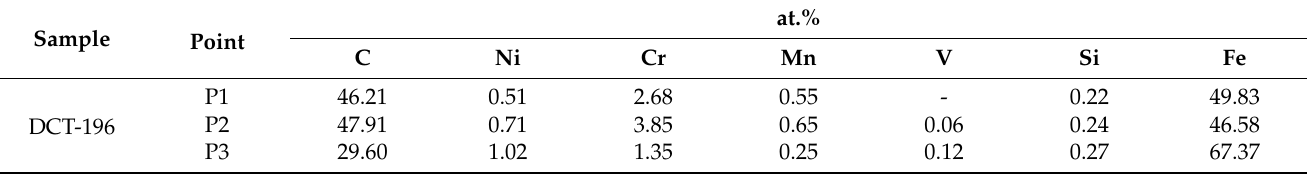
Figure 4. SEM images of the samples at 0.2 mm from the surface: ( a ) CHT, ( b ) CT-80, ( c ) SCT-150, and ( d ) DCT-196; Pictures after PS processing: ( e ) CHT, ( f ) CT-80, ( g ) SCT-150, and ( h ) DCT-196; and histogram of carbide calculation results: ( i ) CHT, ( j ) CT-80, ( k ) SCT-150, and ( l ) DCT-196. Table 3. EDS results of points P 1 , P 2 , and P 3 .